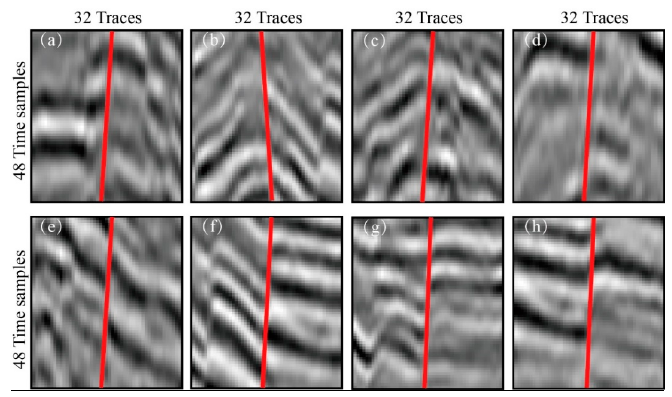
Figure 6. Examples of real samples and corresponding labels.